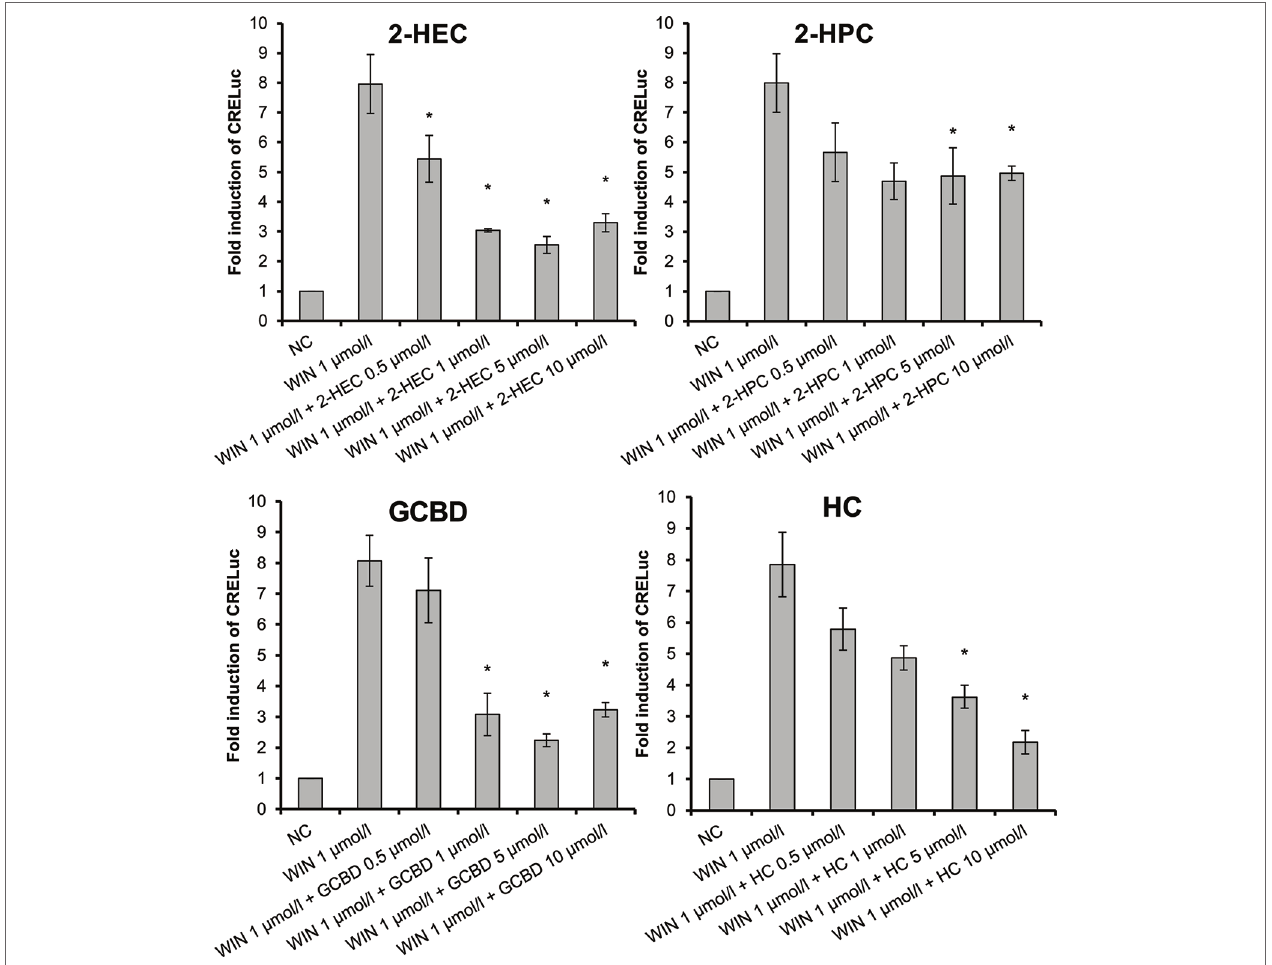
FigURE 3 | CB1‑receptor‑mediated antagonistic effect of 2‑HEC ( 1 ), 2‑HPC ( 2 ), GCBD ( 3 ), and HC ( 5 ) given as fold induction of CRE‑luc; GCBD, 2,3‑dihydroxypropyl cannabidiolate, HC, n ‑hexyl‑cannabidiolate, NC, negative control; 2‑HEC, 2‑hydroxyethyl cannabidiolate; 2‑HPC, 2‑hydroxypentyl cannabidiolate; WIN, WIN 55212‑2; error bars represent SEM, * p < 0.1.